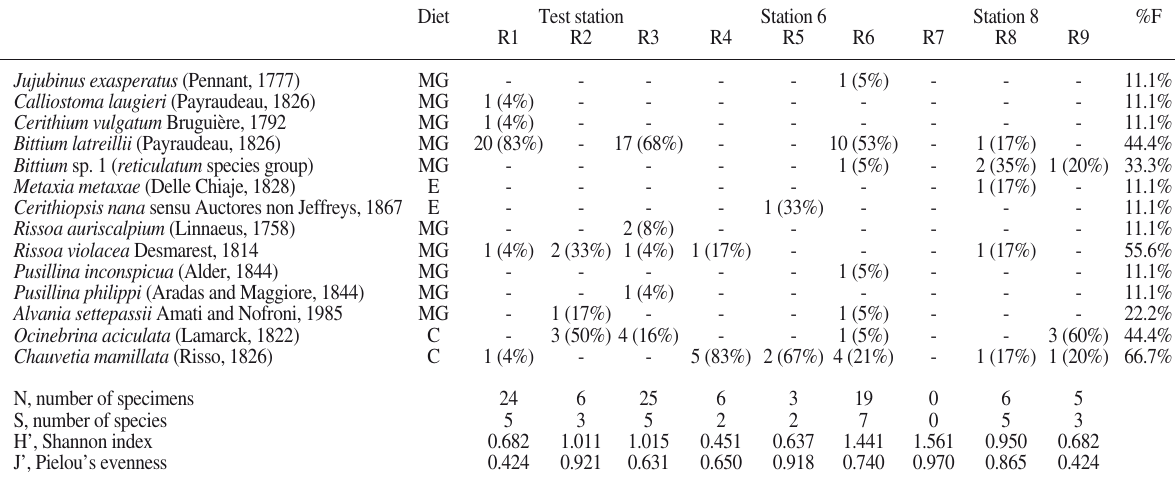
be treated separately in the following paragraphs. The SIMPER routine highlights that differences between leaves and rhizomes originate from the different fre- quencies of abundant species ( Bittium latreillii ), the different abundances of species found in both levels soa violacea ) and the exclusive presence of species in one of the two levels, mainly on the rhizomes, like Mu- ricopsis cristata , Gouldia minima , Raphitoma linearis , Striarca lactea and Nassarius incrassatus . Moreover, the samples from the rhizomes are more similar to each other (average similarity 46.15) than to the samples from the leaves (average similarity 29.87), which is shown clearly by the non-metric MDS in Figure 3. Fig. 2 – Dendrogram for hierarchical clustering of all replicates The molluscan assemblage on the leaves from the rhizome layer of Posidonia oceanica stations (standard- ized data, square root transformed data, Bray-Curtis similarity coef- The species collected on the Posidonia leaves and ficient, group-average linkage) their abundance are given in Table 2. No replicates have any significant differences, nor have the stations (ANOSIM, p>0.05). From a population structure point of view, species richness in replicates varies from 2 to 7, the Shannon diversity index (H’) ranges from 0.451 to 1.441 and the evenness (J’) ranges from 0.424 to 0.921 (Table 2). The diversity and evenness indices are influenced by dominant species (Table 2, between brackets). The dominant species in replicates R1, R3, R6 and R8 was Bittium latreillii . The dominant species at stations R2 and R9 was Ocinebrina aciculata , while at stations R4 and R5 it was Chauvetia mamillata . The most frequent species are Chauvetia mamillata (present in 6 repli- Bittium latreillii and Ocinebrina aciculata (4 repli- Fig. 3 – Non-metric multi-dimensional scaling plot representing cates, 44.4%). Eight species (57.1%) are present in a replicates of the Posidonia oceanica leaves (solid triangles) and single replicate only. rhizomes (empty